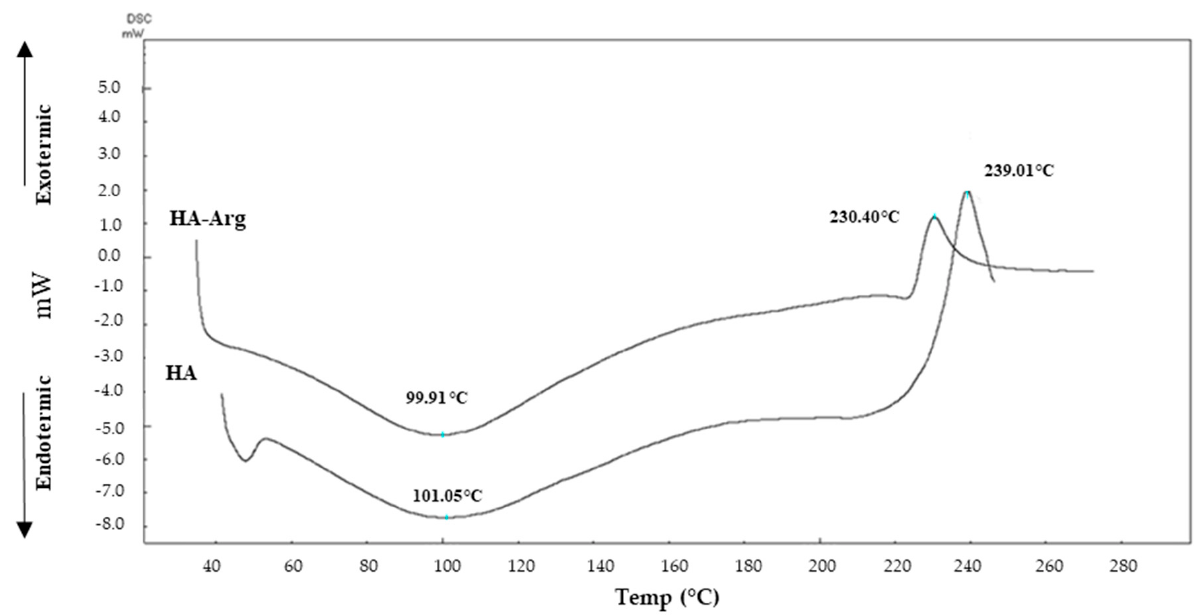
Figure 3. Thermograms of the native HA and HA-Arg.